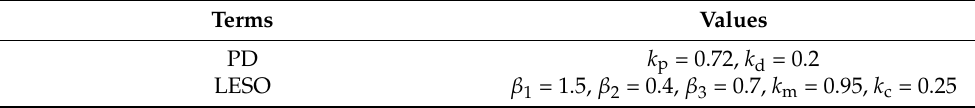
Table 3. Parameters of the compensator. Figure 9. The performance of the stabilized control in simulation: ( a ) the typical controller; ( b ) the proposed scheme.